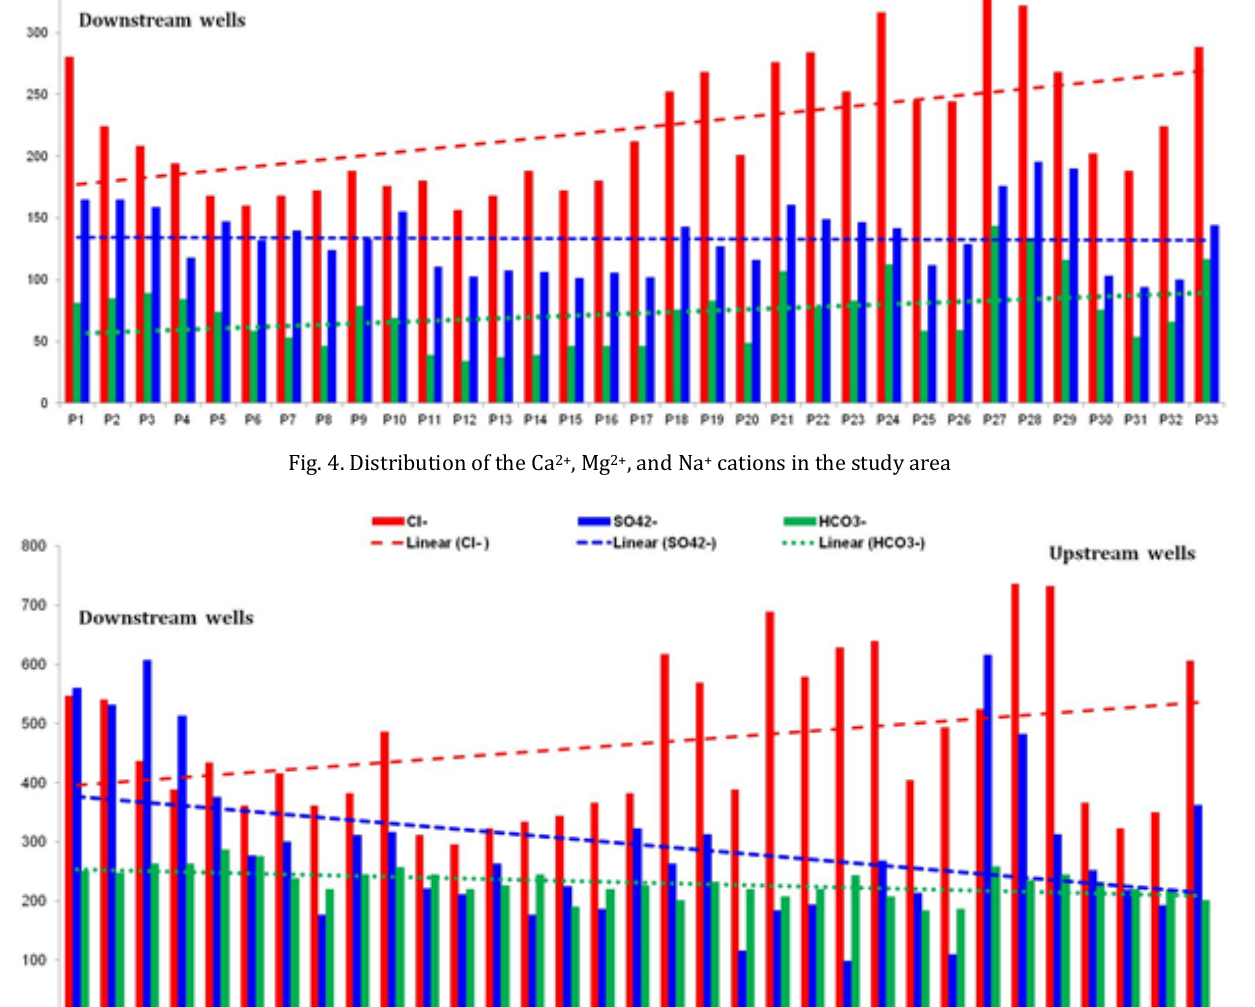
Fig. 5. Distribution of the Cl - , SO 42- and HCO 3- anions in the study